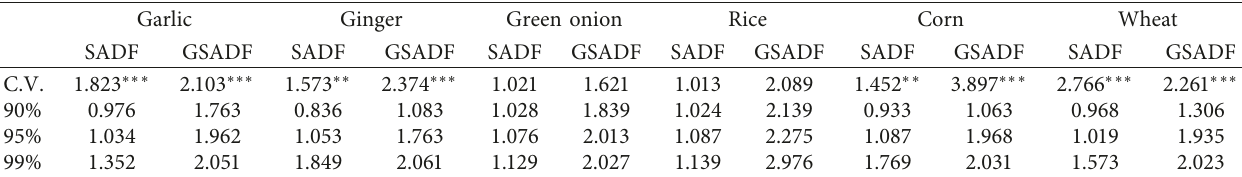
Table 2: Bubble detection results in Chinese agricultural commodity markets of 20